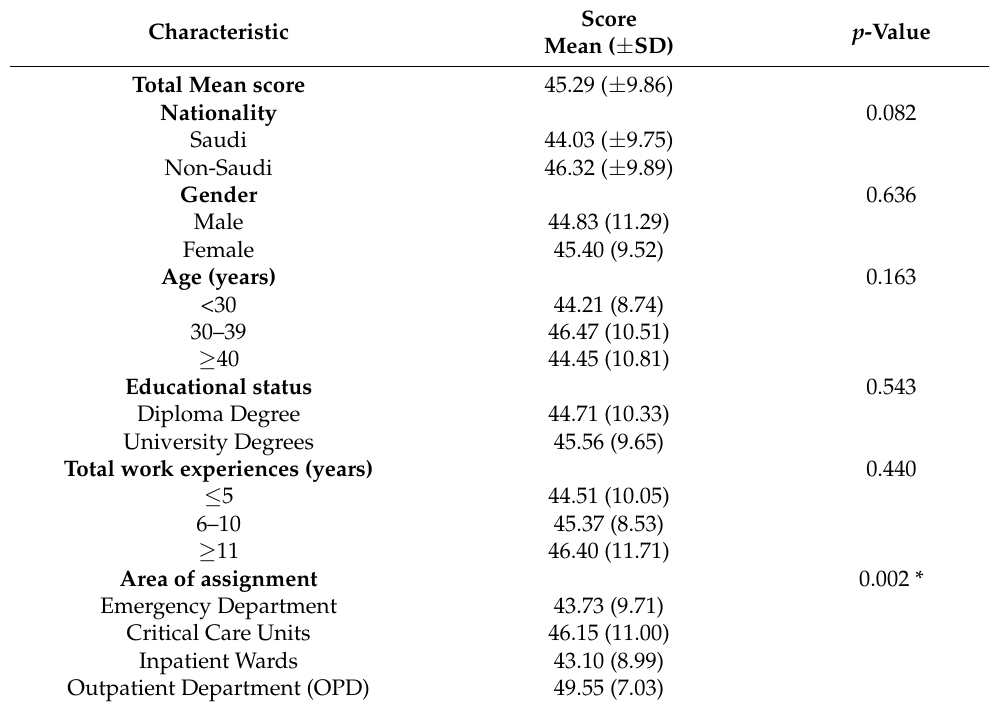
Table 3. Nurses’ mean scores based on their